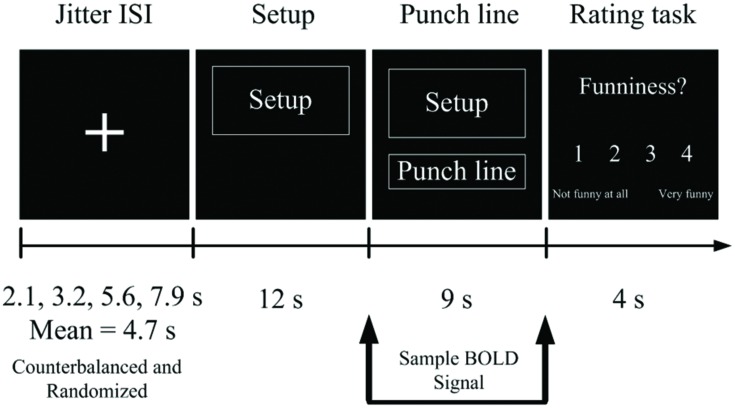
An experimental trial timeline during the scanner. Stimuli were presented in an event-related fMRI paradigm.